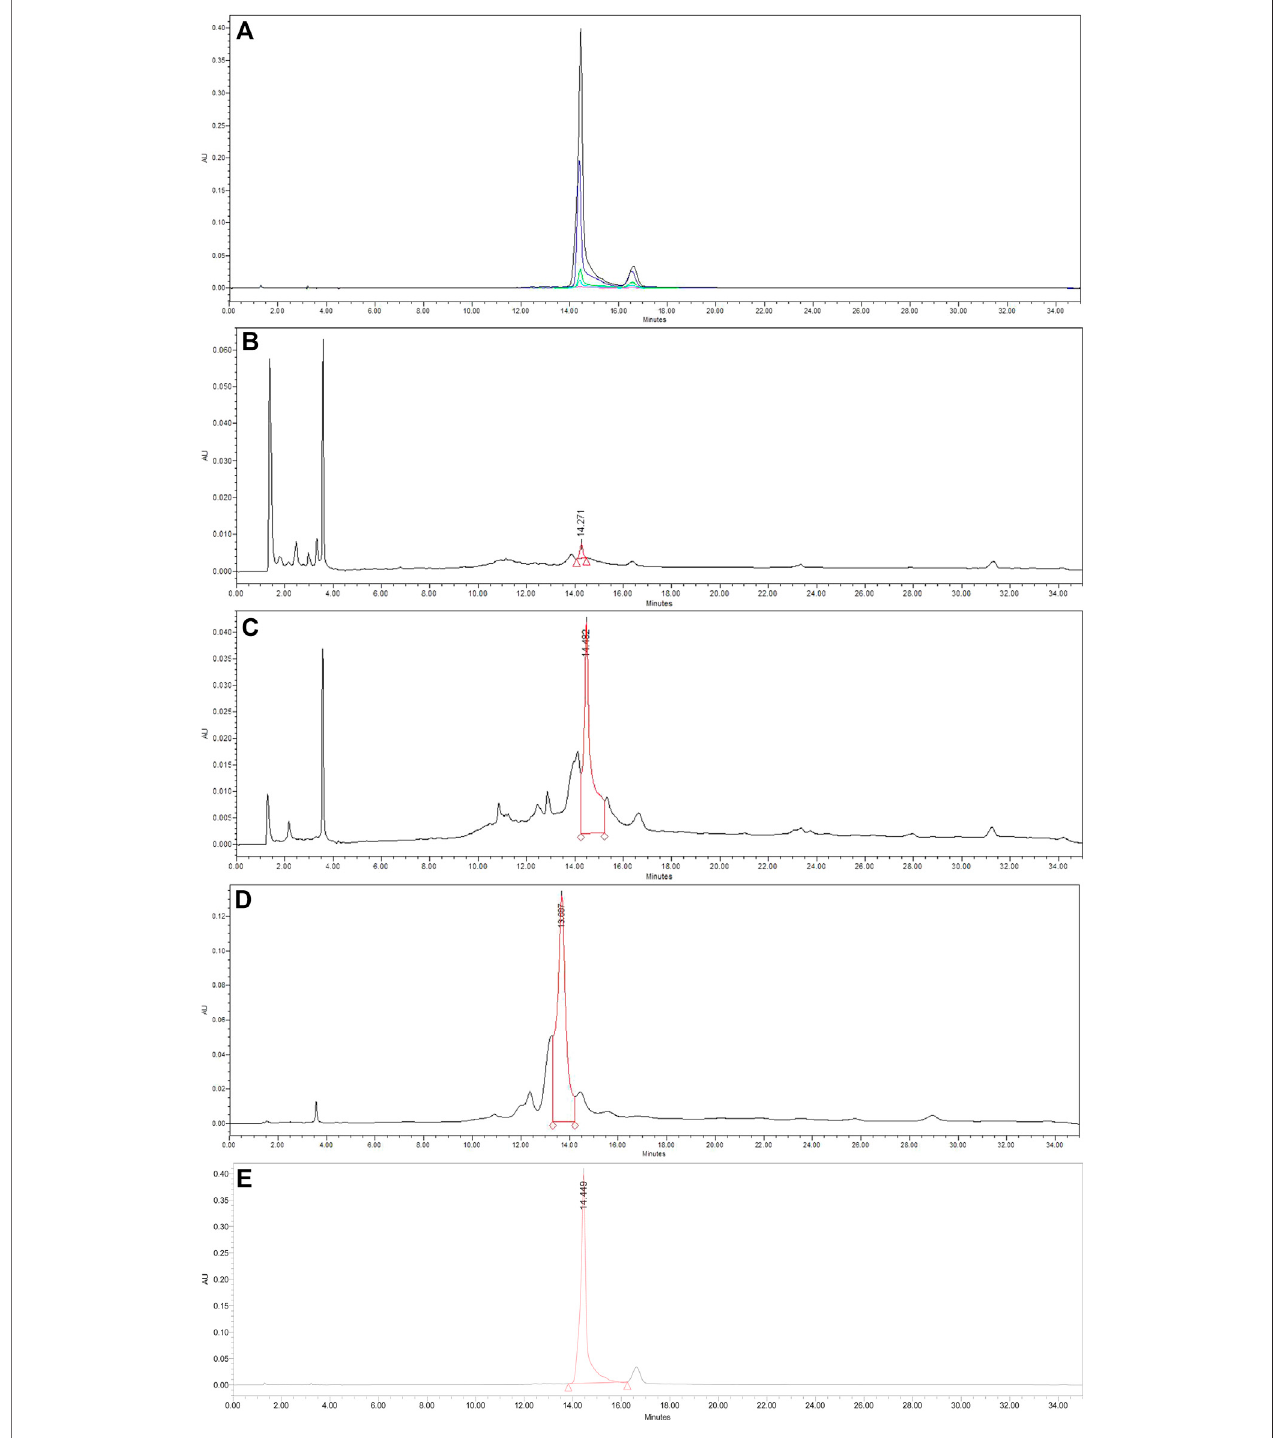
FIGURE 4 | Representative HPLC chromatograms of (A) compound standard, (B) U60E [branch (with bark) 60% pre-ethanol A extract], (C) USCFR [branch (with bark) supercritical extraction residue 60% edible ethanolic extract from U. davidiana ], (D) USCFREA [ethyl acetate layer extract of USCFR], and (E) catechin- glycoside – rich fraction. U60E = 1,000 ppm, USCFREA = 1,000 ppm, USCFR = 1,000 ppm, and catechin-glycoside – rich fraction = 1,000 ppm.